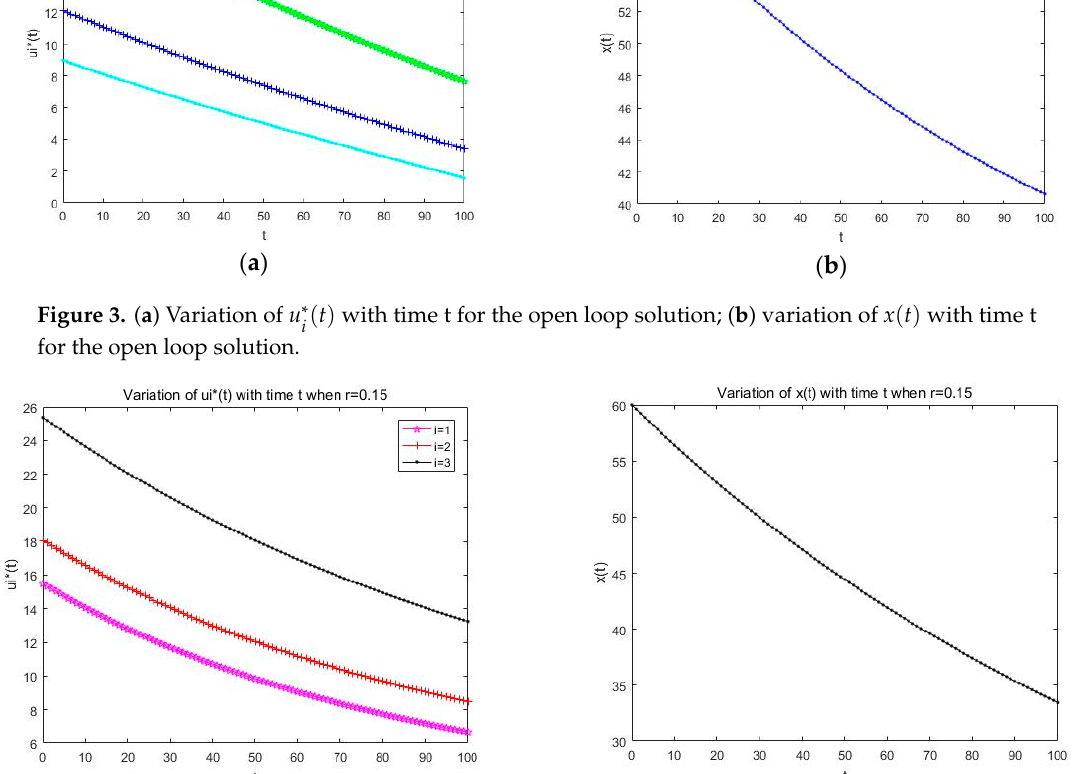
Figure 5. ( a ) Variation of 𝑢 (cid:3036)∗ (𝑡) for the feedback solution under infinite horizon at t = 10; ( b ) variation of 𝑢 (cid:3036)∗ (𝑡) for the feedback solution under infinite horizon at the end of the game.